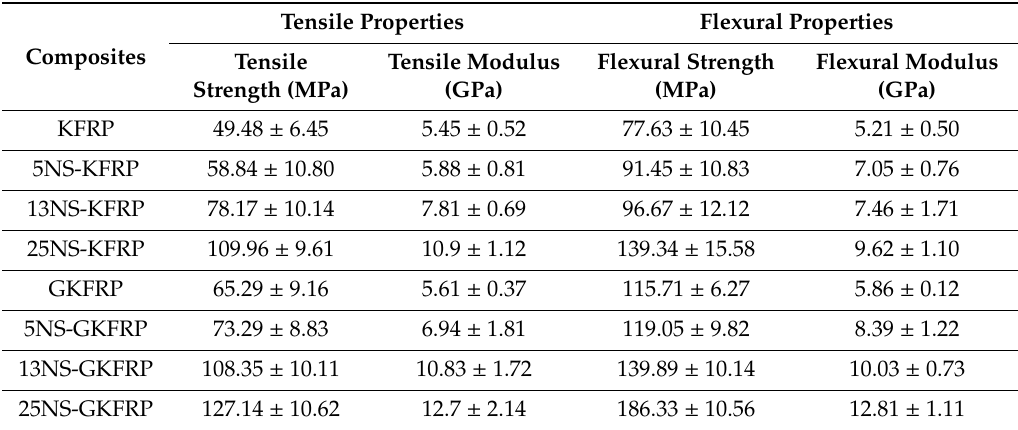
Table 2. Tensile and flexural properties of KFRP and hybrid GKFRP with inclusion of nanoparticles.